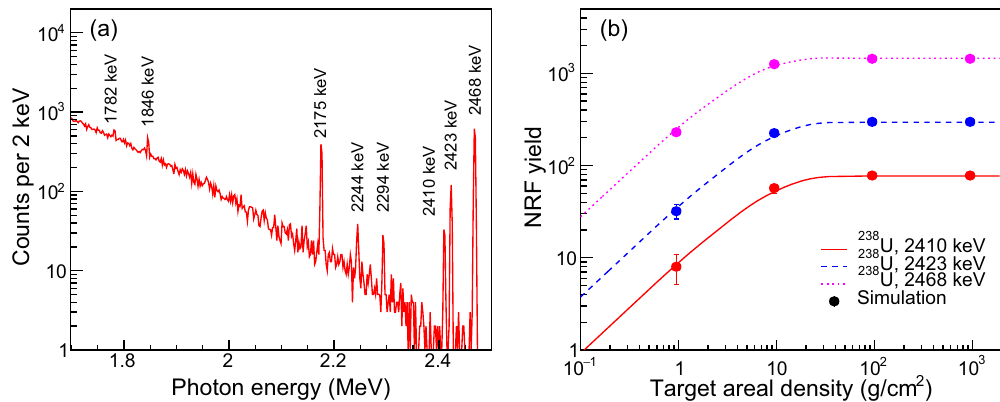
Figure 2. ( a ) Simulation results of energy spectrum recorded by the HPGe detectors at an incident γ flux of 10 11 photons for target areal density of 200 g/cm 2 . ( b ) Count rates as a function of target areal density for three NRF lines of 238 U with high energy of 2410, 2423 and 2468 keV. The curves present semi-analytical model predictions (via integration of Eq. (1)), while the points correspond to NRF yields extracted from the energy spectrum. 1 σ statistical Here error bars denote ±